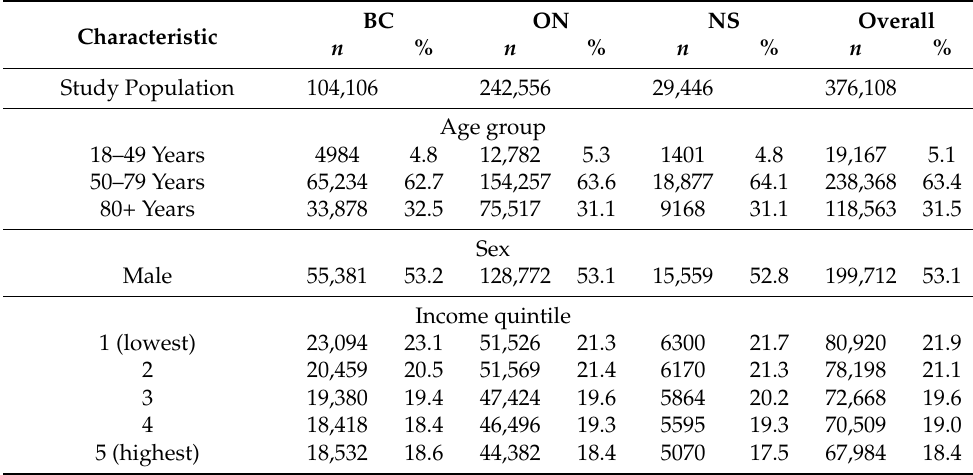
Table A1. Socio-demographic data by province,